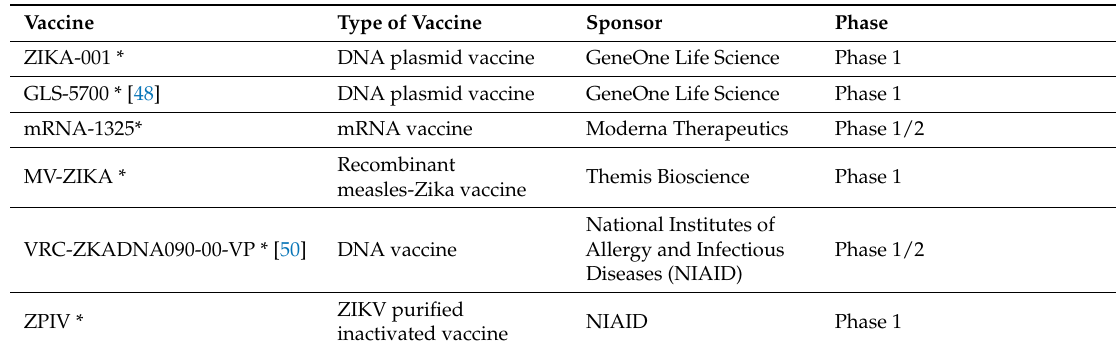
Table 1. Types of vaccines and phases of